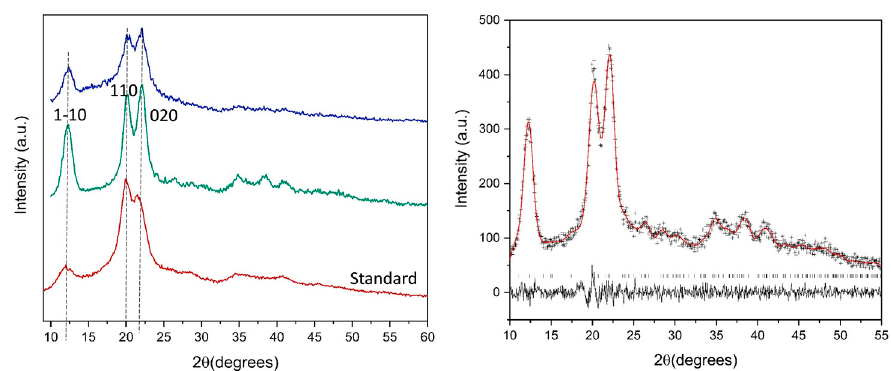
Figure 5. ( Left ): XRD for the mercerized CNC samples showing the typical pattern of the polymorph II (red-CNC-MF standard, green-CNC-S, Blue-CNC-NS). ( Right ): Rietveld plot for the structural refinement of CNC-S.